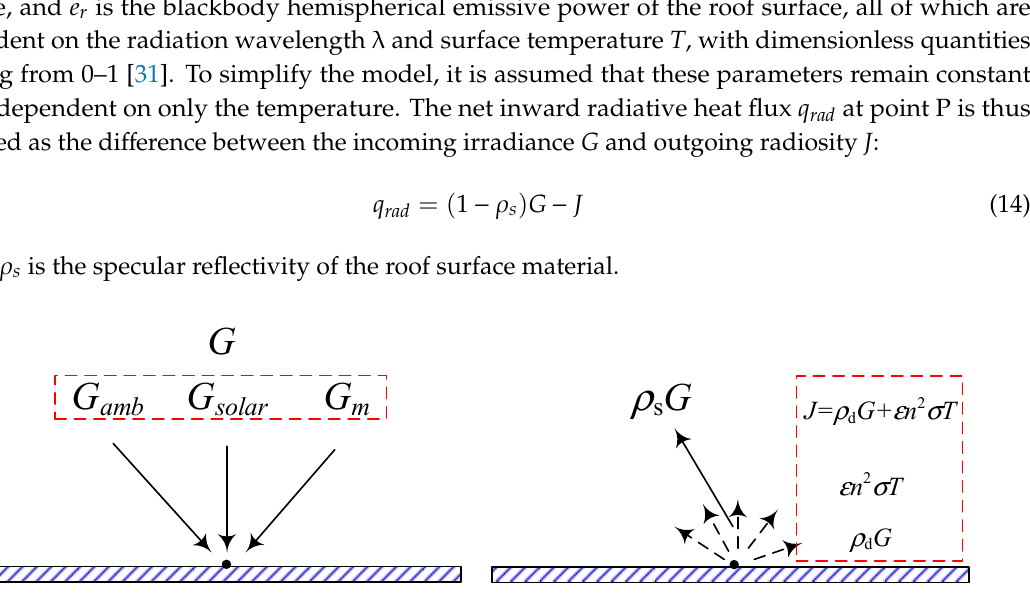
Figure 3. Schematic diagram of the radiation transfer process of a roof surface.